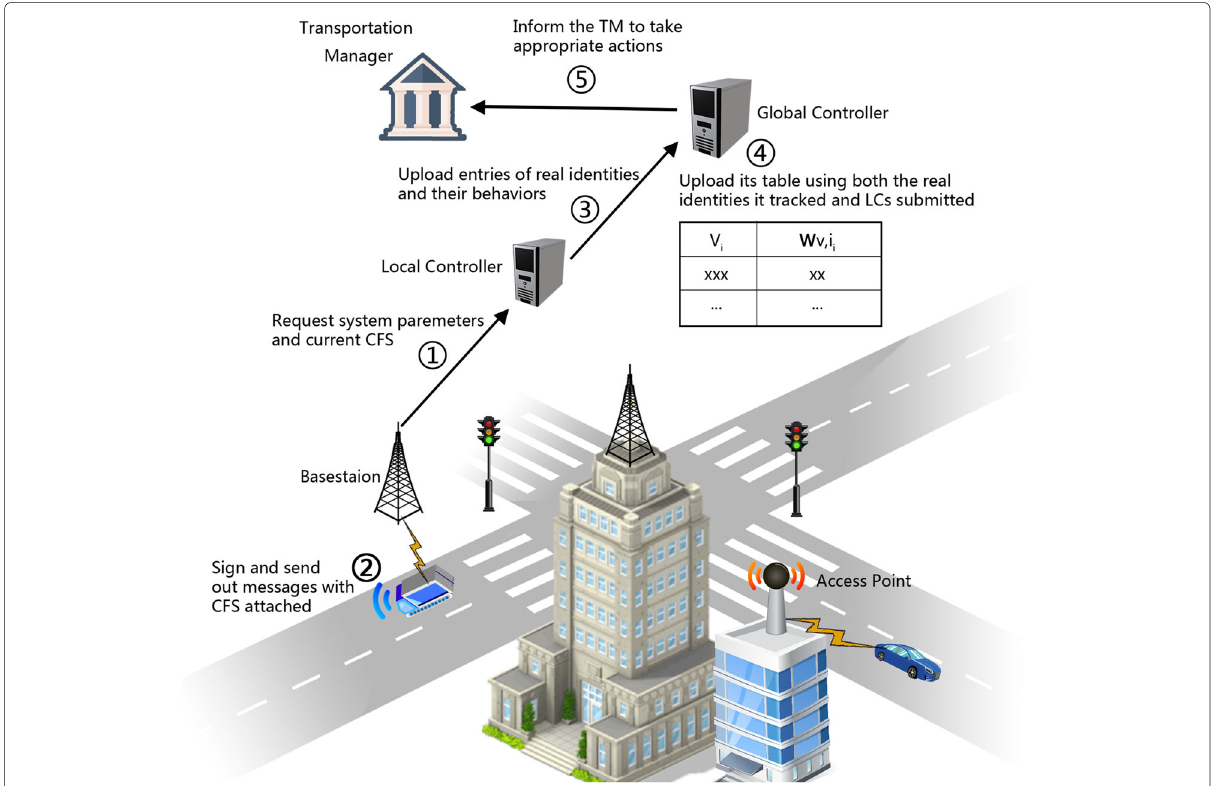
Fig. 3 How the system model